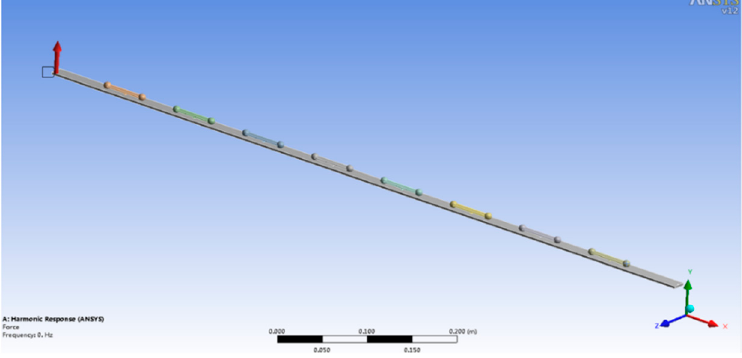
Figure 8. Structural model in the finite element method (FEM) simulation.